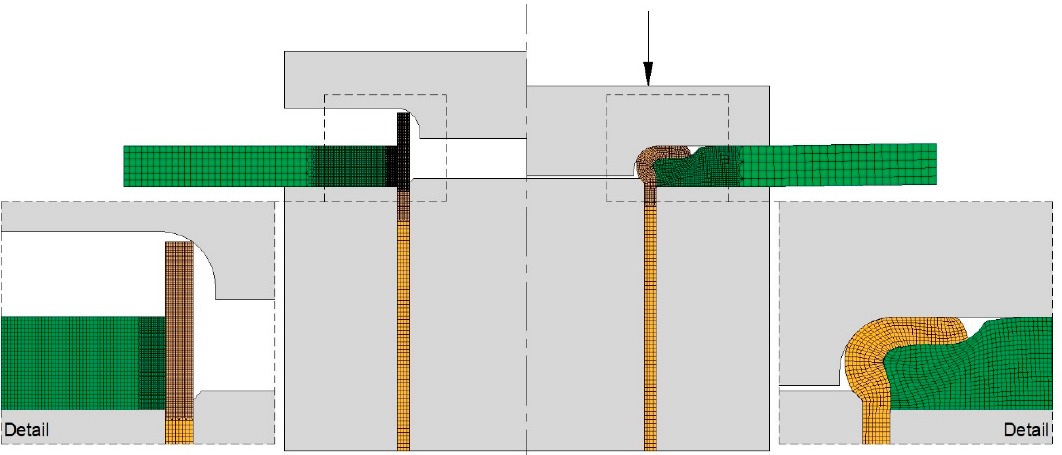
Figure 6. Finite element simulation details of the meshes in the beginning and at the end of the joining by forming process ( r c = 3 mm and h = 6